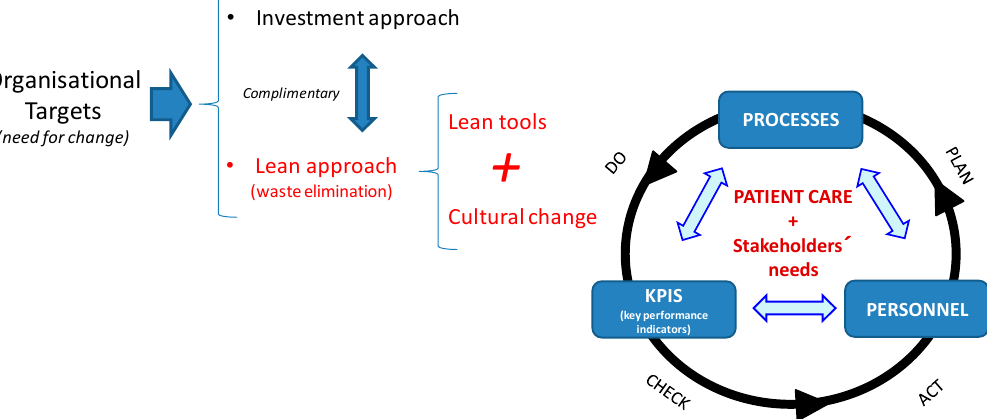
Figure 2. Theoretical basis of the model for implementing lean Healthcare.